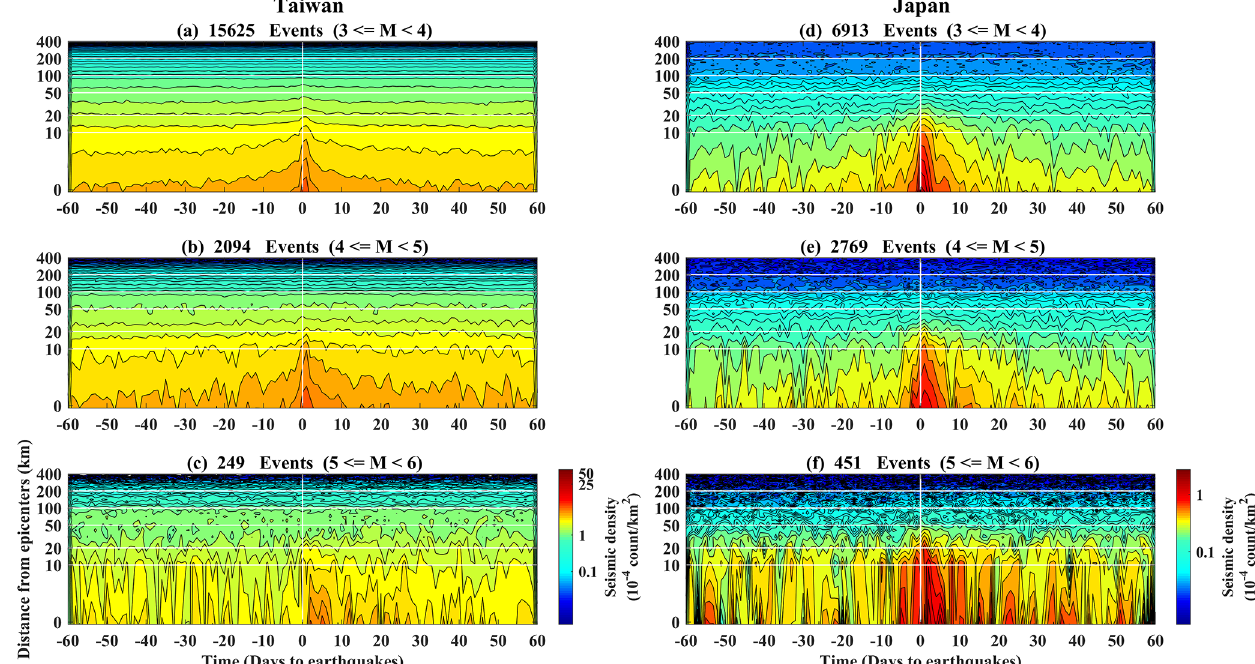
Figure 1. Spatiotemporal seismic density distributions in Taiwan and Japan. The seismic densities constructed by using the declustered earth- quake catalogs of Taiwan and Japan are shown in the left and right panels, respectively. The seismic density reveals changes in seismicity at distances from the epicenters ranging from 0 to 400km up to 60d before and after quakes in a particular magnitude group. The superimposed number in each grid is further normalized for a fair comparison by using the total number of quakes and their areas. Notably, the total number of quakes is shown in the title of each